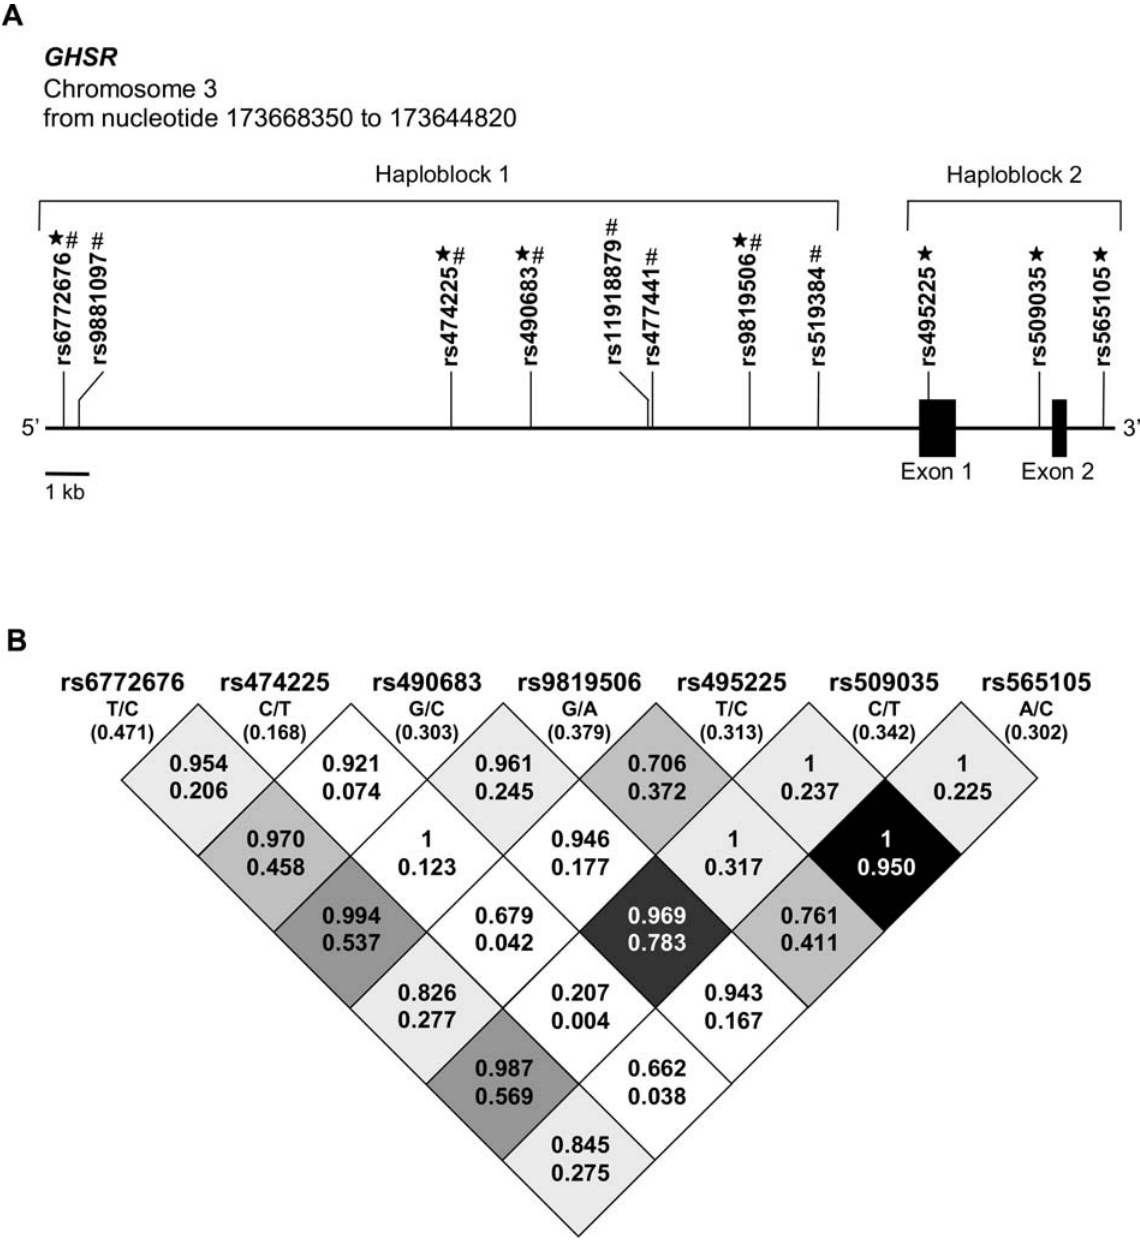
Figure 1. The human GHSR gene and location of SNPs and their LD measures. A. Schematic representation of the human GHSR gene indicating the locations of analyzed single nucleotide polymorphisms (SNPs) that belong to two haploblocks. (black star), SNPs genotyped in the Finnish Diabetes Prevention Study population. # SNPs from HapMap database in transcription factor (TF) binding sites and tested in gelshift assays. B. Standardized pair-wise linkage disequilibria (LD) measures of D’ and r 2 for seven GHSR single nucleotide polymorphisms (SNPs) of the Finnish Diabetes Prevention Study. Major/minor alleles and the minor allele frequency (in parentheses) are included below each SNP identification number. For each cell, the number on the top line is D’ and the number on the bottom line is r 2 . Strength of LD is indicated in greyscale with black denoting strong and white weak LD.